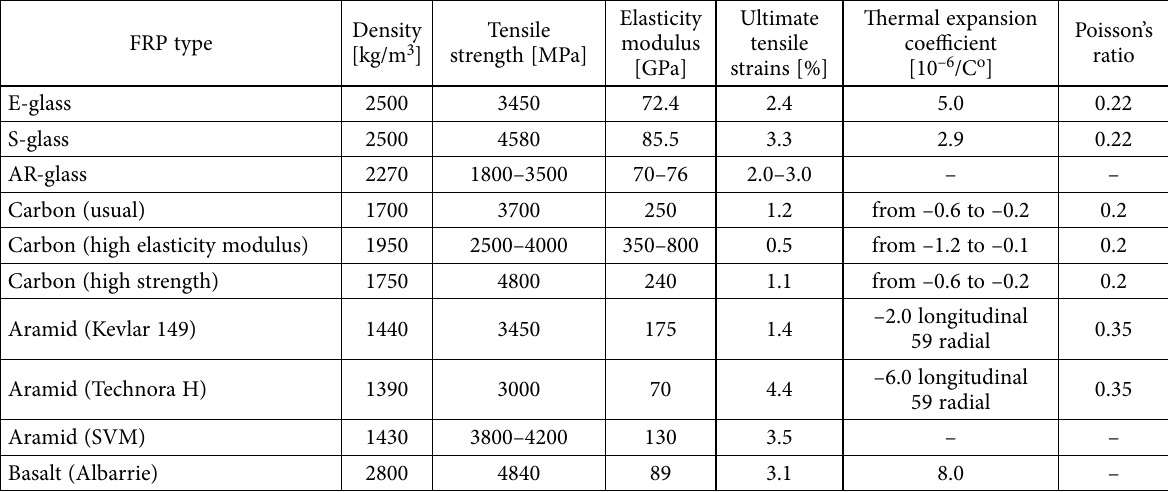
Table 1. Physical and mechanical properties of FRP (Kaklauskas et al. 2012)